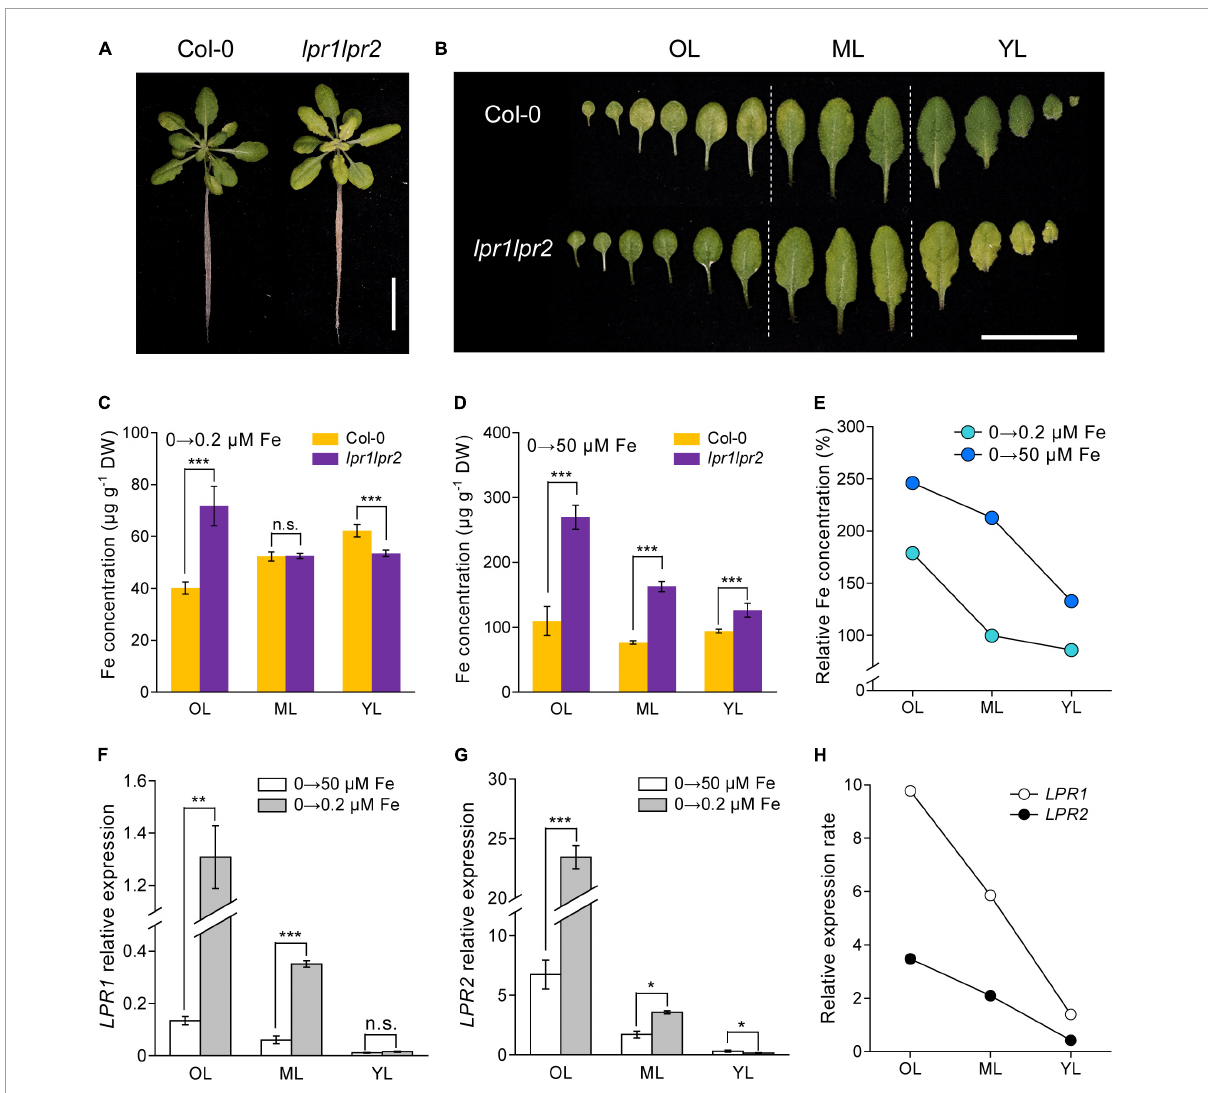
FIGURE4 LPRs alleviate Fe deficiency by preventing Fe allocation to old leaves. (A,B) Phenotypes of Fe-free pre-grown plants resupplied with 0.2 µ M Fe. The Fe concentrations in different leaf positions of Fe-free pre-grown plants resupplied with 0.2 µ M Fe (C) and 50 µ M Fe (D) . (E) Relative Fe concentration in different leaf positions calculated as lpr1lpr2 versus Col-0. OL, old leaf; ML, middle leaf; YL, young leaf. (F,G) Expression of low phosphate root 1 (LPR1) and low phosphate root 2 (LPR2) in different leaf positions of the Col-0 plants. EF1 α and UBQ10 were used as the internal control. (H) Relative expression rates of LPR1 and LPR2 in Col-0 calculated as 0.2 µ M Fe versus 50 µ M Fe treatment. The plants were grown in 0 µ M Fe for 7 days and then resupplied with 0.2 or 50 µ M Fe for another 5 days. Values are means ± SD of five replicates in (C,D) and four in panels (F,G) . Asterisks indicate a significant difference at * P < 0.05, ** P < 0.01, *** P < 0.001 by Tukey’s test. Scale bars 2